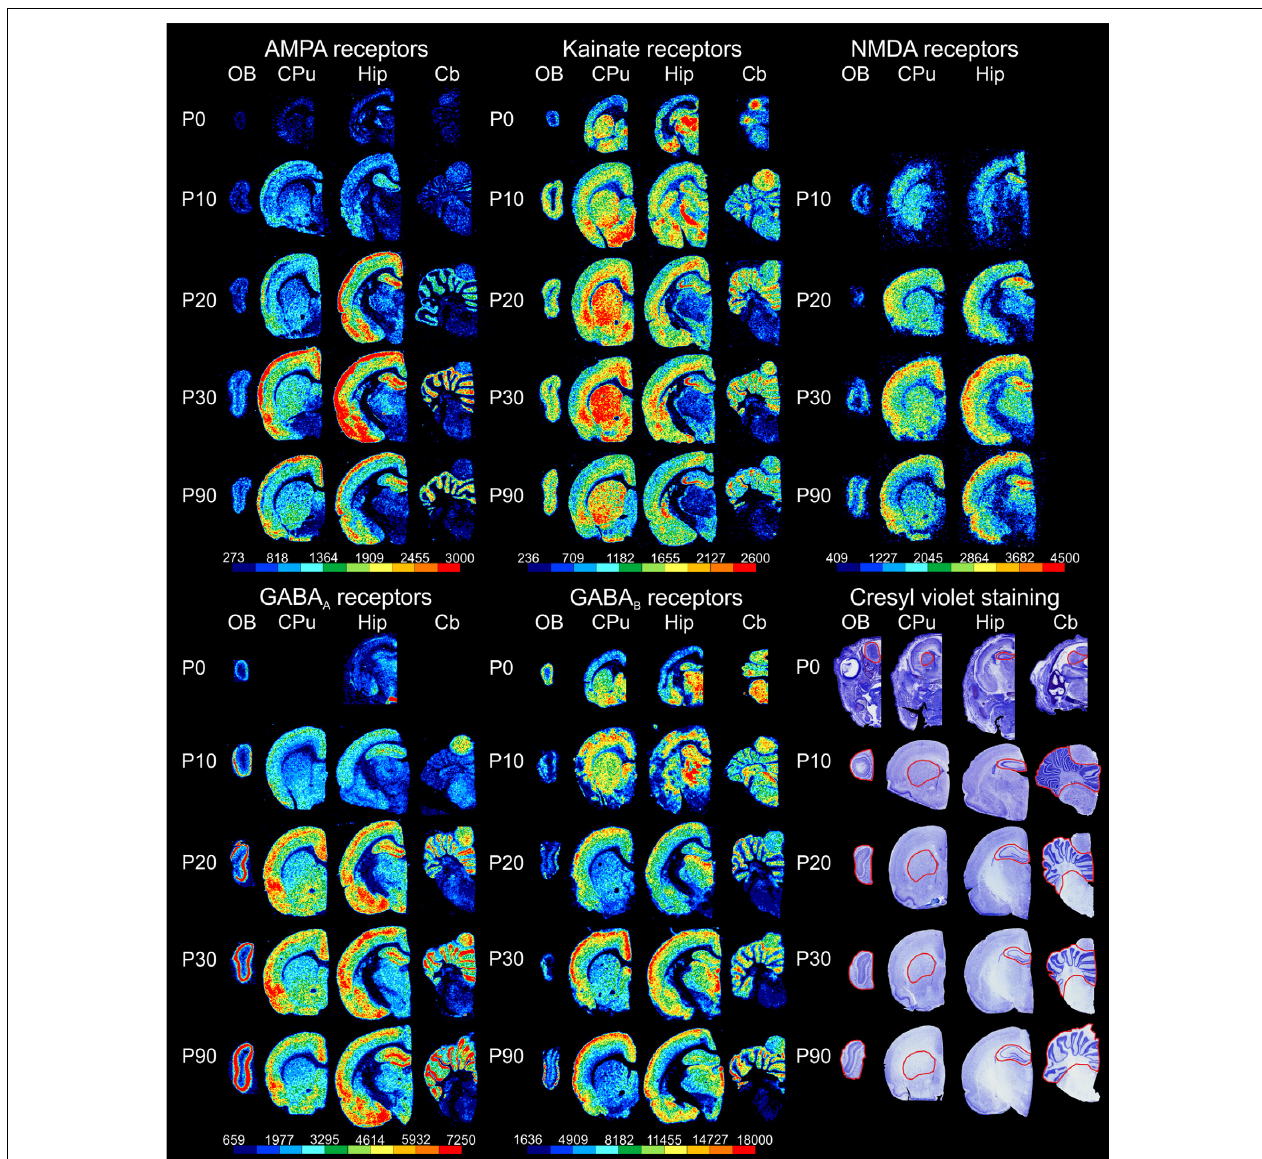
FIGURE 3 | Exemplary sections through representative rostrocaudal levels for the examined brain regions [olfactory bulb (OB), striatum (caudate-putamen, CPu), hippocampus (Hip) and cerebellum (Cb)] depicting color-coded autoradiographic images of glutamatergic and GABAergic receptor densities as well as images of cresyl violet staining at different developmental stages (postnatal day of Wistar rat: P0, P10, P20, P30 and P90). Scale bars code for receptor densities in fmol/mg